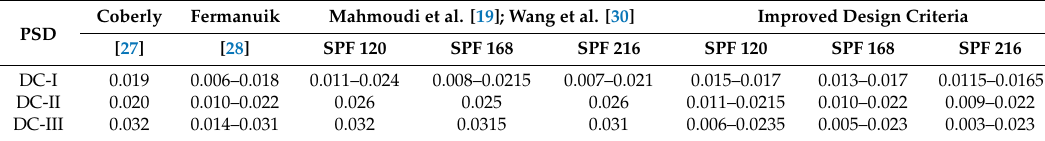
Table 5. Comparison of the slot size for DC-I, II, and III for the normal SAGD condition from di ff erent design criteria (all sizes are inches).